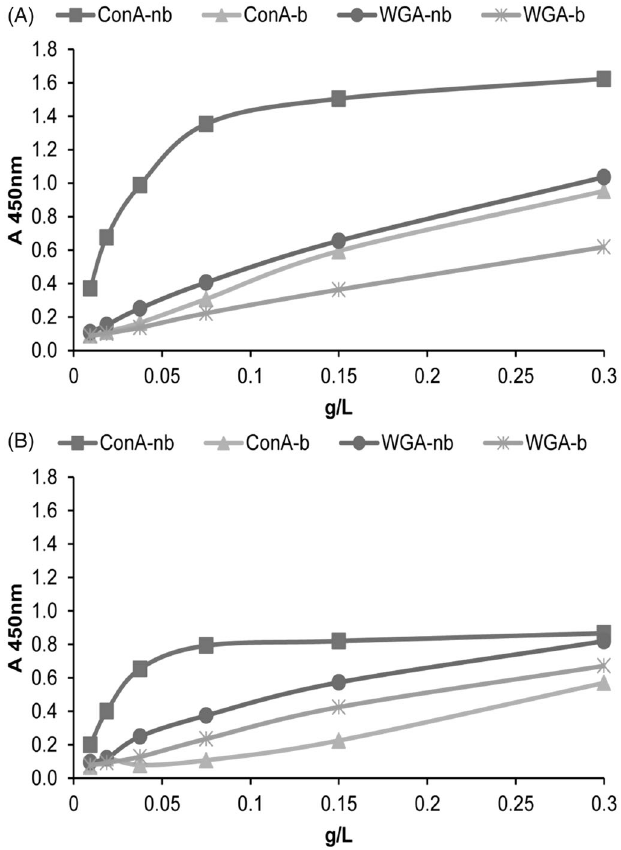
Figure 3. Surface glycosylation of seminal prostasomes from normozoospermic men separated by lectin-affinity chromatography (LAC). LAC-separated fractions of seminal prostasomes from normozoospermic men: Con A-non-bound (Con A-nb), Con A-bound (Con A-b), WGA-non-bound (WGA-nb), and WGA-bound (WGA-b) fractions were immobilized and re-probed with Con A (A) and WGA (B) by solid-phase binding